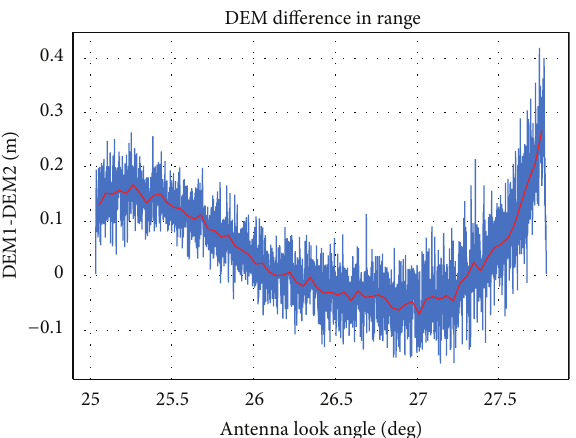
Figure 6: Resulting phase pattern deviation in flight direction of the difference between the two